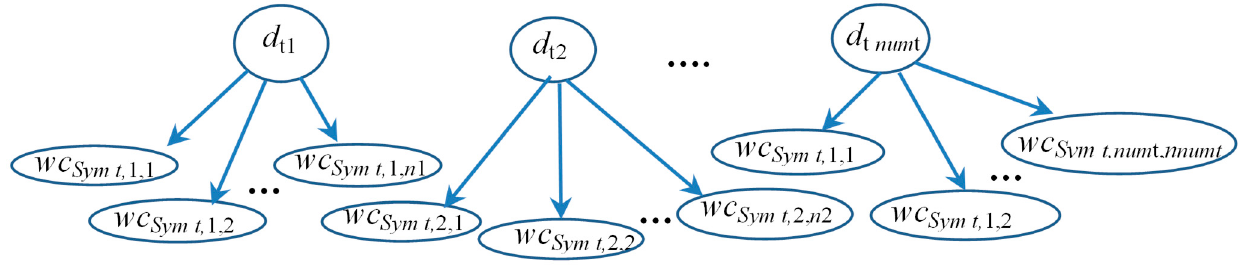
Figure 6. Show d t,i -SymGroup dt,i pairs having CErel after grouping correct determined d t,i wc Symt,ij pairs having CErel by d t,i .